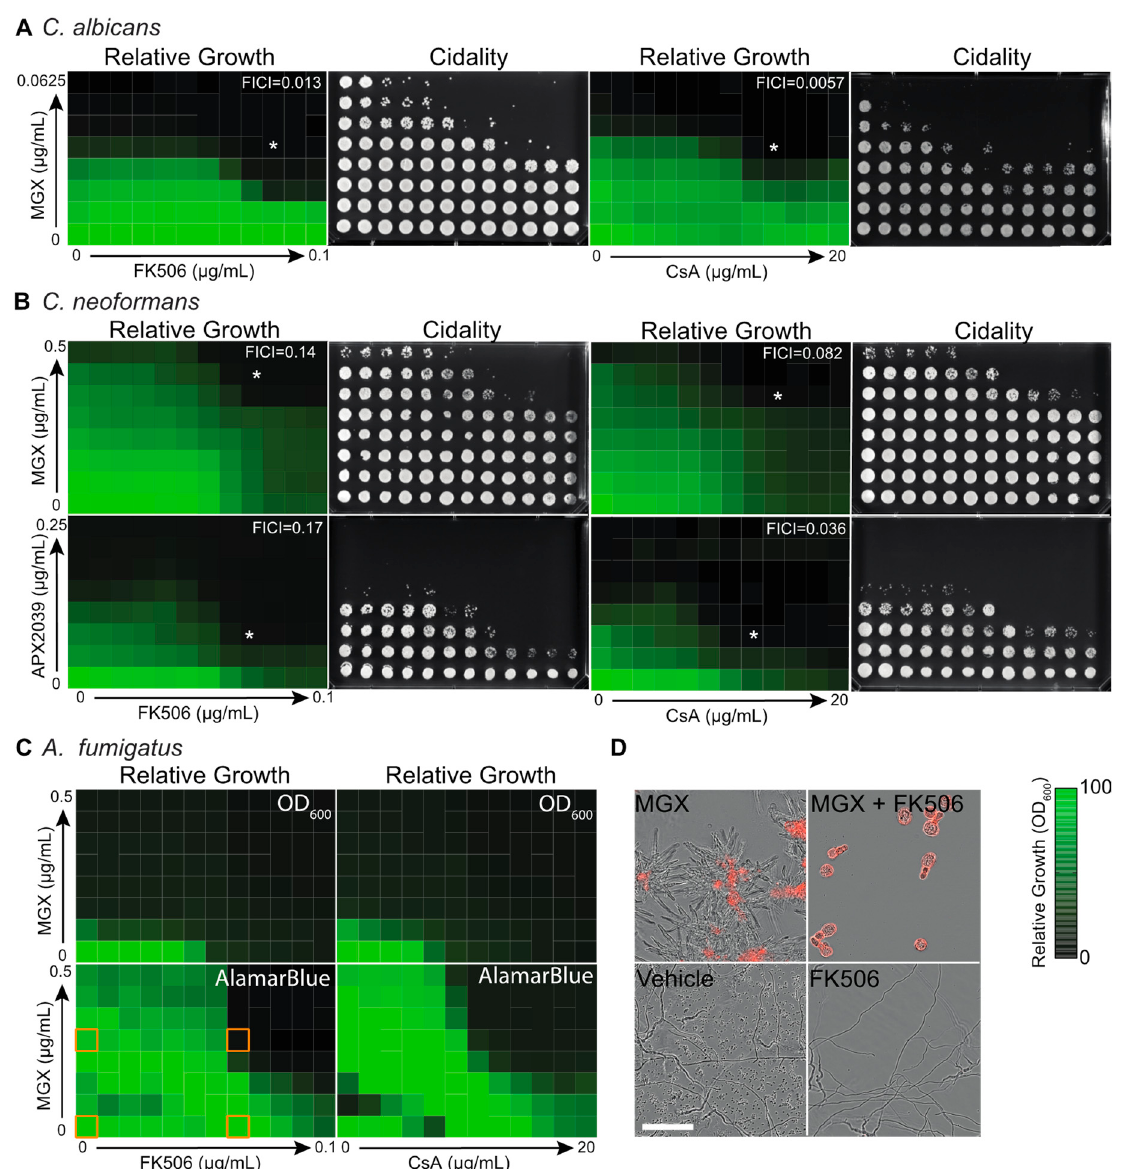
Figure 1. Gwt1 inhibitors synergize with calcineurin inhibitors to kill diverse human fungal pathogens. ( A ) FK506 and CsA synergize with MGX to inhibit growth of C. albicans . Two-fold dose response matrices for MGX and FK506 or MGX and CsA tested against C. albicans . Growth was determined by OD600 after 24 h incubation in YPD medium and normalized to vehicle control wells. Data are mean relative growth for three replicate wells from a representative experiment. The lowest FICI value is inset (white text), and the corresponding well marked with an asterisk. To assess viability after combination drug treatments, cells were transferred onto drug-free YPD agar and photographed after culture for an additional 48 h. A scale bar for all heat-map depictions presented in panels ( A – C ) is provided to the right of panel ( D ). ( B ) FK506 and CsA synergistically interact with MGX or the structural analog APX2039 to inhibit growth of C. neoformans . Assays were performed as in ( A ), except optical densities were determined after 48 h growth. ( C ) FK506 and CsA synergistically interact with MGX to inhibit growth of A. fumigatus . Assays were performed as in ( A ), except optical densities were determined at 48 h. Relative metabolic activity was assessed by measuring Alamar blue dye reduction. Data are mean relative fluorescence intensity normalized to vehicle control